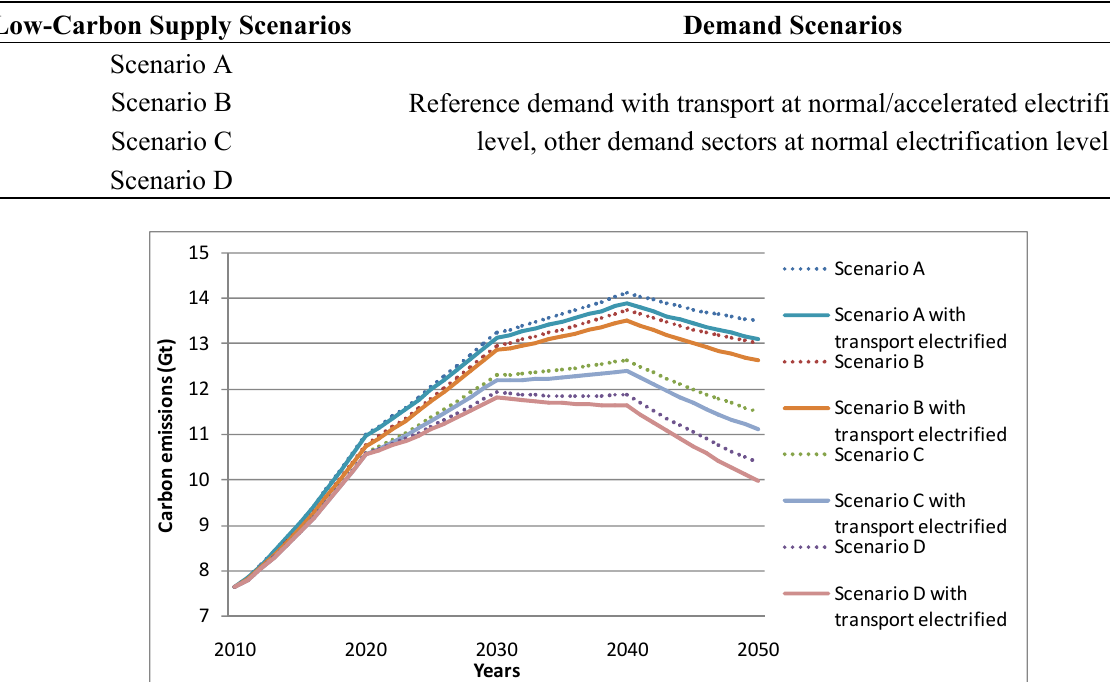
Table 15. Scenarios used for analyzing contributions of electrifying transport to carbon dioxide mitigation in different low-carbon supply scenarios.